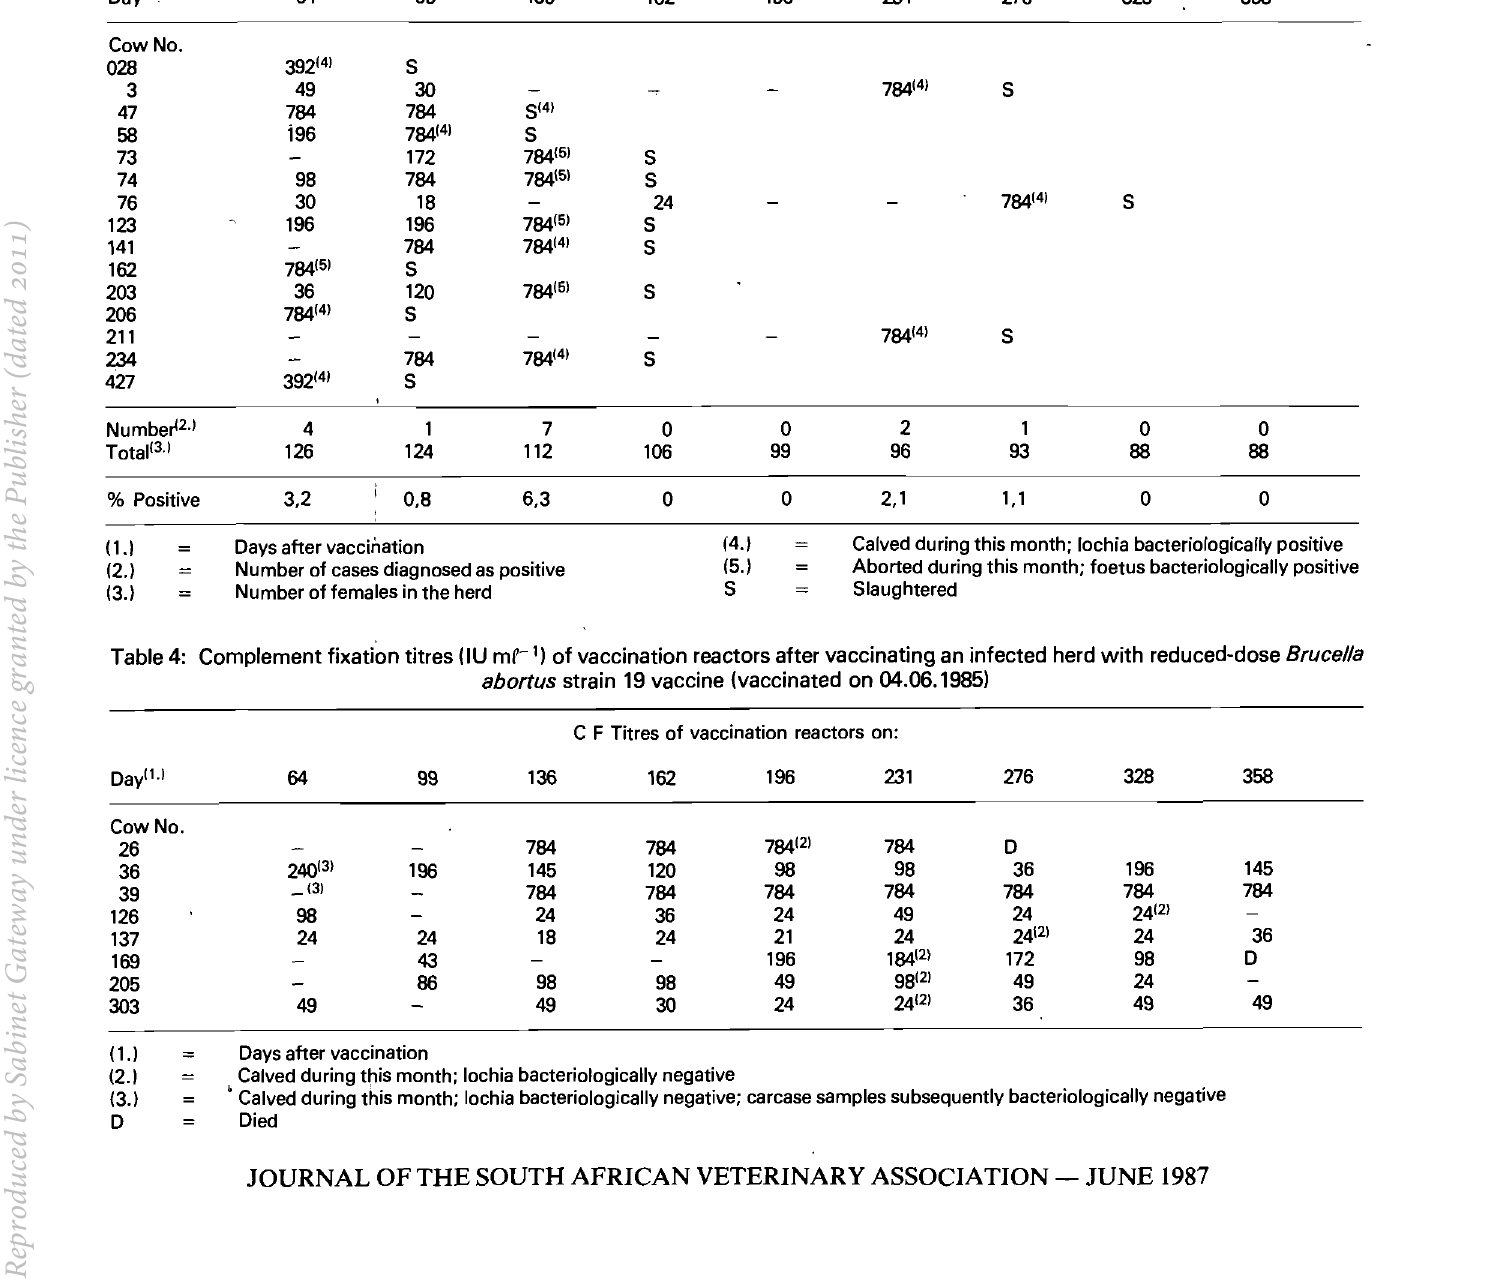
Table 3: Complement fixation titres (lU mp-I) of reactors after vaccinating an infected herd with reduced-dose Brucella abortus . strain 19 vaccine (Vaccinated on 4.6.1988) CF titres of positive cases on: